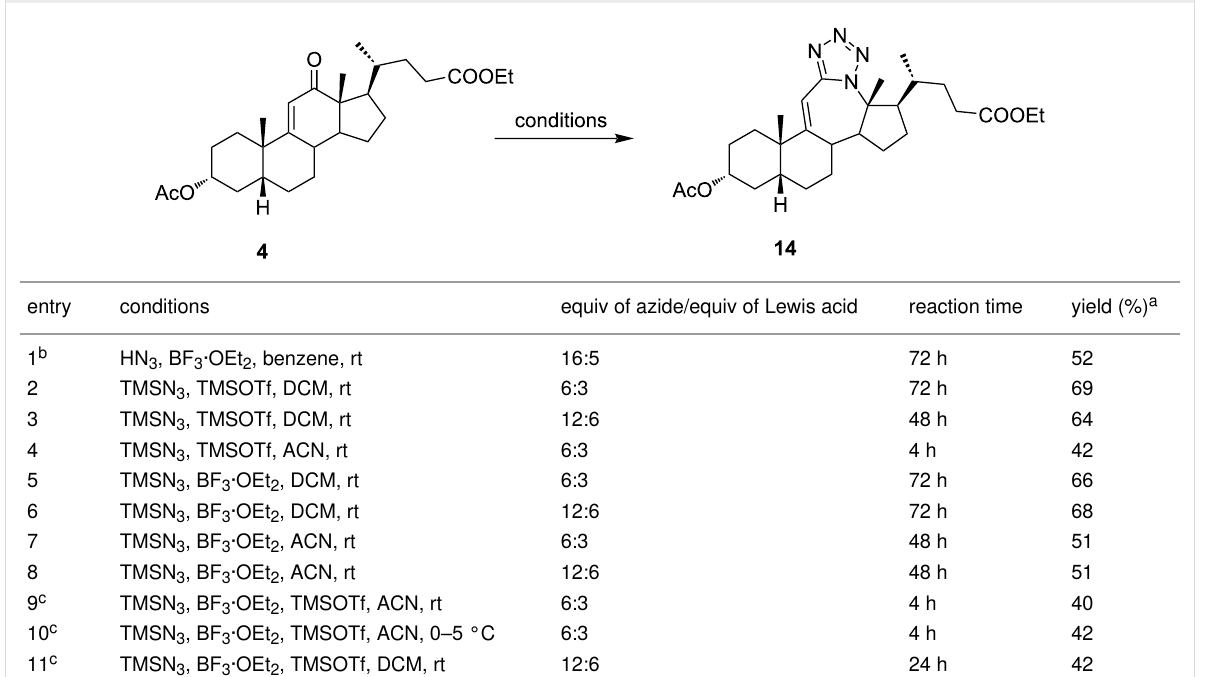
Table 2: Optimization of reaction conditions for the transformation of